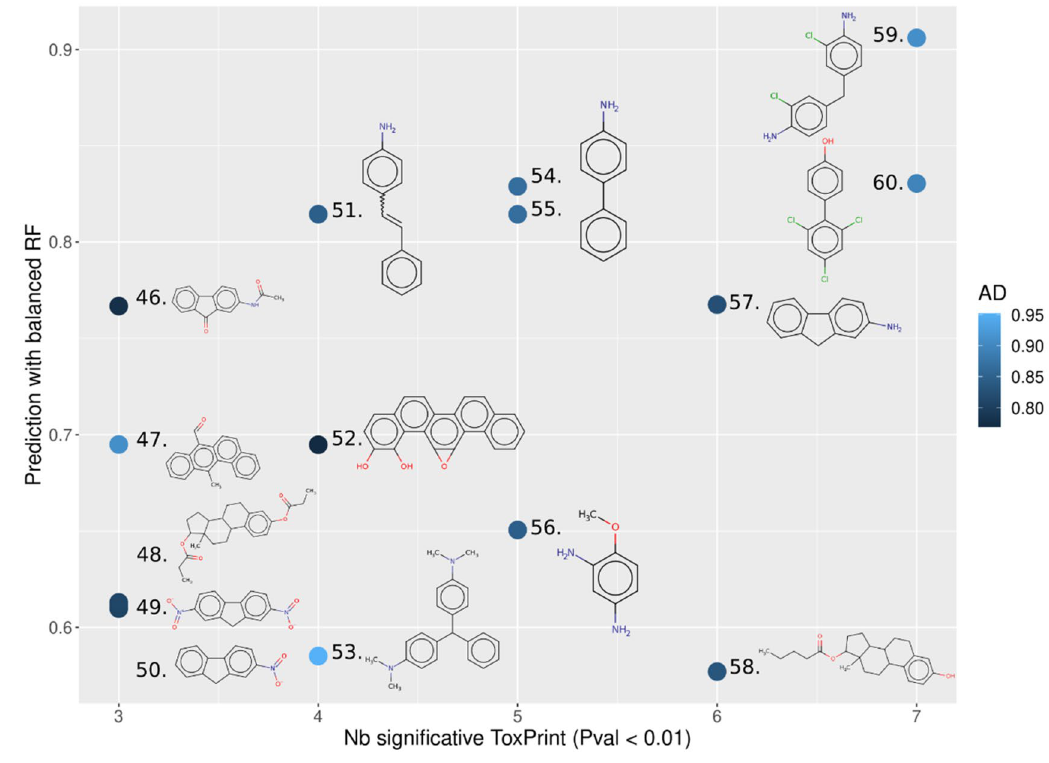
Figure 13. Predicted P4up chemicals from the MC set of chemicals. The x-axis represents the number of ToxPrints significant for P4up, the y-axis represents the probability prediction to be P4up, and the applicability model is in blue (minimal similarity score with the first chemicals in the training set). Chemicals structural are represented in the figure: 46. n-(9-oxo-2-fluorenyl)acetamide (3096–50–2), 47.